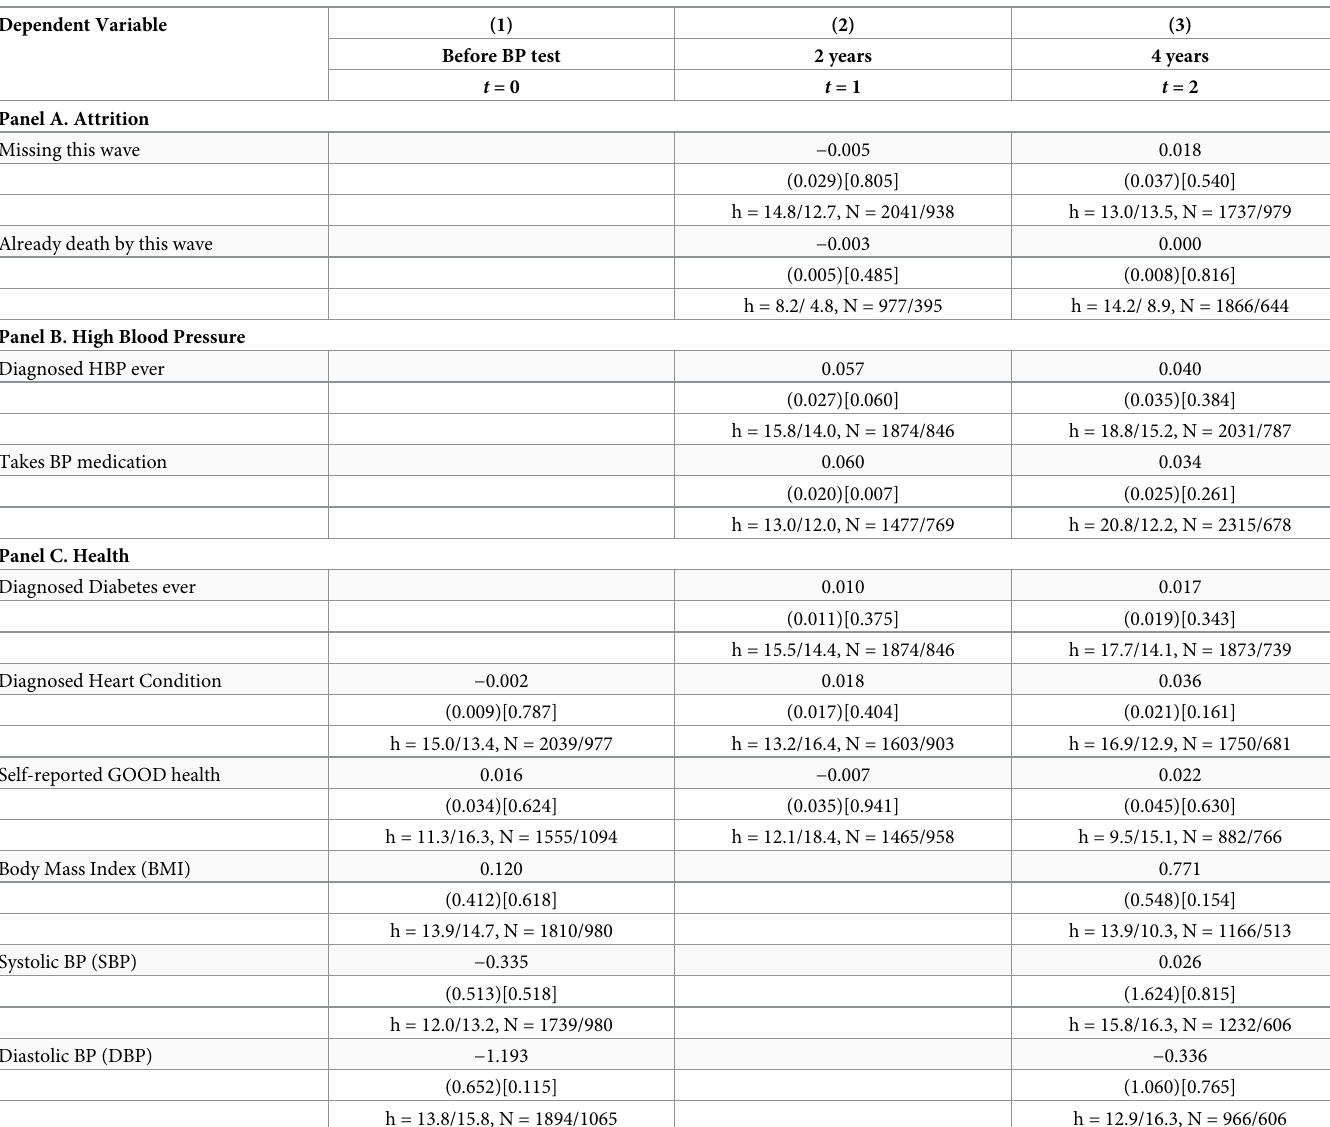
Table 3. The effects of information on potential hypertension